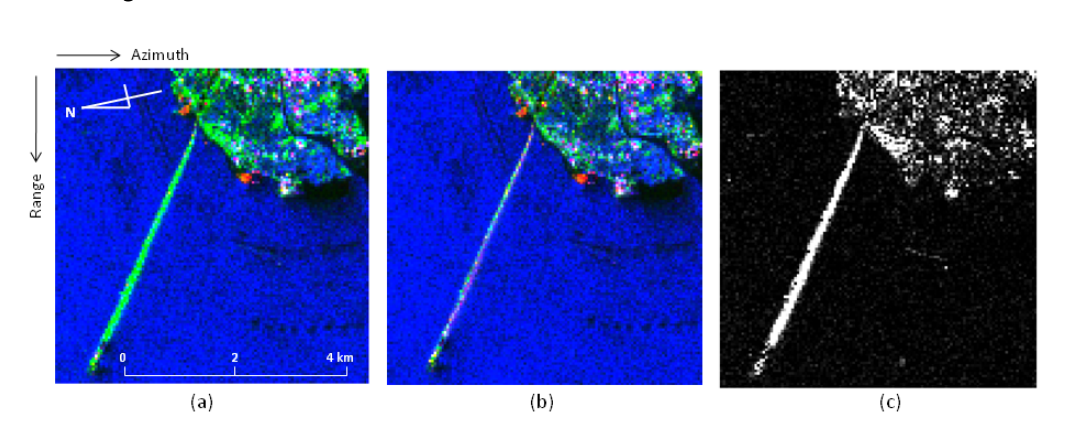
Figure 5. Tokyo Bay Aqua-Line (Highway) near the area of Figure 2. The central coordinate of each image is approximately at (139 ◦ 53’E, 35 ◦ 26’N). ( a ) 4-CSPD image without rotation. ( b ) 4-CSPD image with rotation. ( c ) Difference of P d component between the left and the middle image.